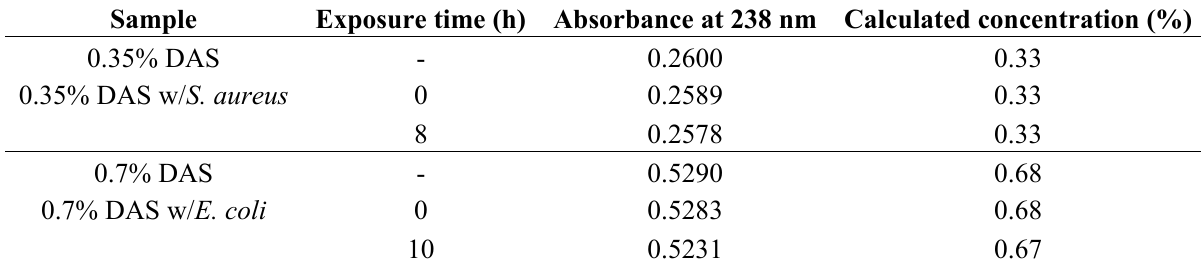
Table 1. Dialdehyde starch (DAS) concentration during bacterial inactivation at room